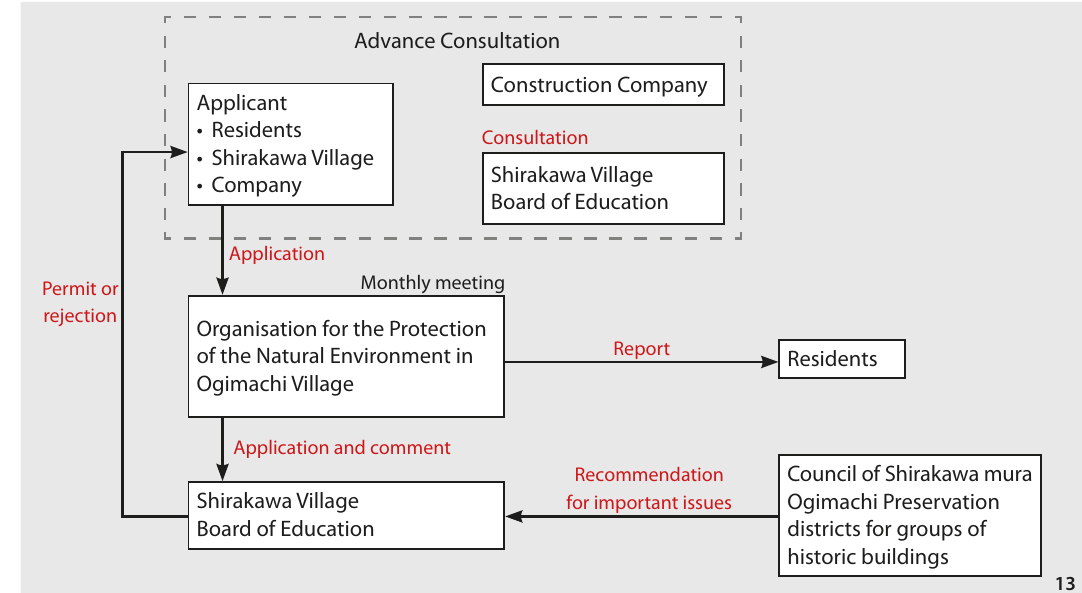
Figure 13 Permission process in Ogimachi village (Source: the